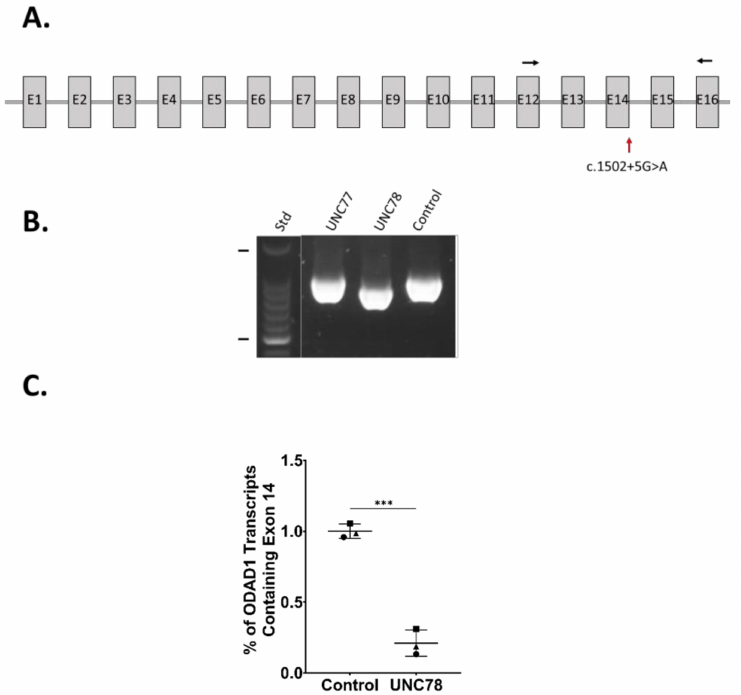
Figure 3. ( A ) Schematic of the ODAD1 transcript (NM_001364171.2) showing the relative locations of the c.1502+5G>A variant (red arrow) and the primers used for RT-PCR (black arrows). ( B ) The major product produced by RT-PCR of UNC78 was shorter than that produced from UNC77 and an unrelated control, due to the skipping of exon 14. ( C ) ddPCR demonstrated the expression of a greatly reduced level of ODAD1 transcripts containing exon 14 in samples from UNC78. Symbols, datapoints from individual experiments; lines, the mean and std. dev.; ***, p < 0.001 by a two-tailed t -test. ( n = 3